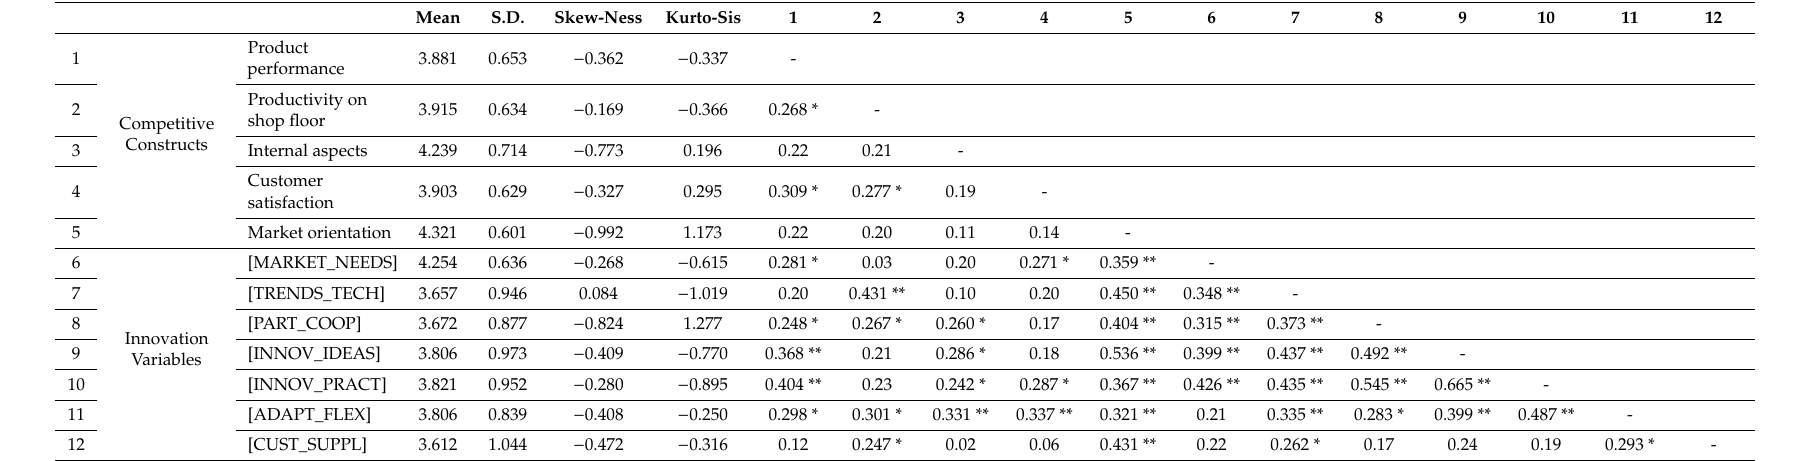
Table 6. Correlation matrix and descriptive